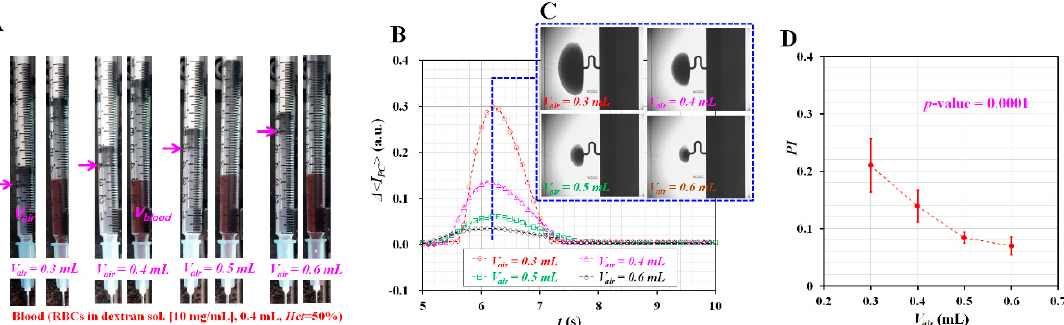
Figure 2. Quantitative evaluations of the effect of the air cavity adjusted inside the ACS on pressure index ( PI ). Here, blood sample (normal RBCs in dextran solution [10 mg / mL], Hct = 50%, and blood volume = 0.4 mL) were sucked into the ACS. The air cavity was compressed about V comp = 0.3 mL consistently. ( A ) Snapshots obtained at varying air cavity ( V air = 0.3, 0.4, 0.5, and 0.6 mL). ( B ) Temporal variations of ∆ < I PC > with respect to V air . ( C ) Microscopic images captured at a specific time when ∆ < I PC > had the highest value depending on V air . ( D ) Variations of pressure index ( PI ) with respect to V air .